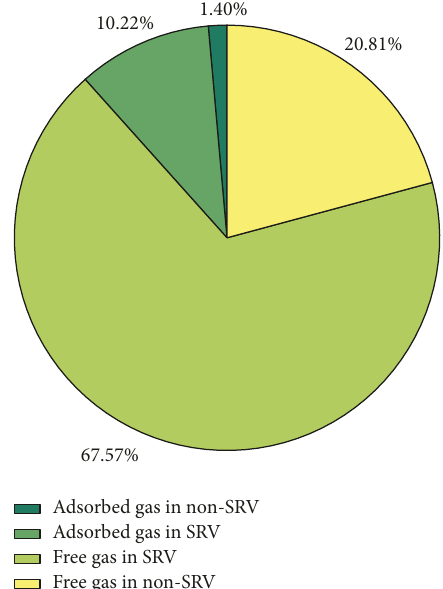
Figure 5: The fractions of free gas and absorbed gas in SRV and non-SRV regions in terms of cumulative production.